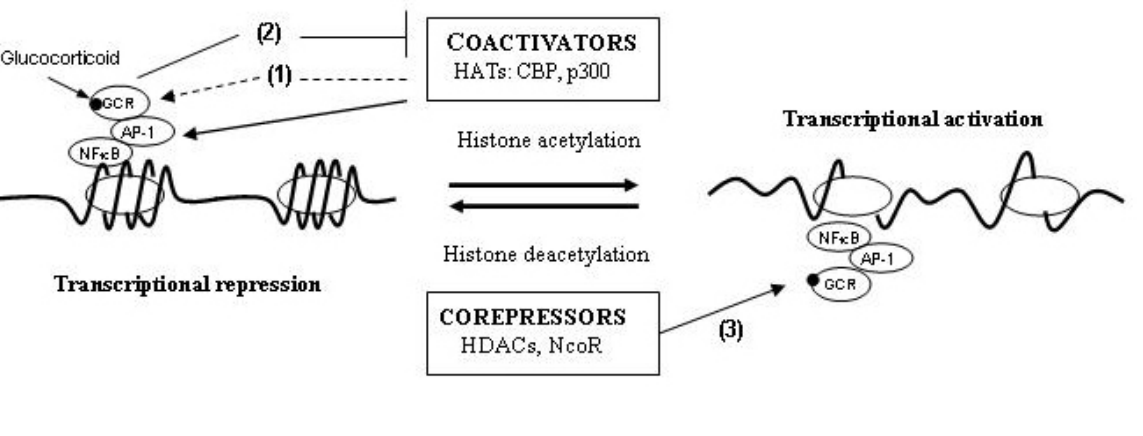
FIGURE 1. Effect of GCR on chromatin remodelling, HATs, and HDACs. Gene expression and repression are regulated by modification of core histones. In the resting state, DNA is tightly coiled around histones and is inaccessible to transcriptional cofactors and RNA polymerase II. Upon binding to DNA, NF κ B and AP-1 recruit and activate coactivator proteins, such as CBP and p300/CBP-associated factor, which have intrinsic HAT activity. Histone acetylation results in slackening of chromatin and unwinding of DNA, allowing the transcriptional machinery to gain access to genes and initiate transcription. Deacetylation is controlled by corepressor proteins, such as HDACs and NcoR, and is associated with gene repression. Activated GCRs may interact with HATs and HDACs to regulate their function. Suggested mechanisms of GR transrepression include (1) GCR competes with NF κ B and AP-1 for binding to coactivators, (2) direct suppression of HAT activity of coactivators by GCR, (3) recruitment of corepressors by GCR to reverse histone